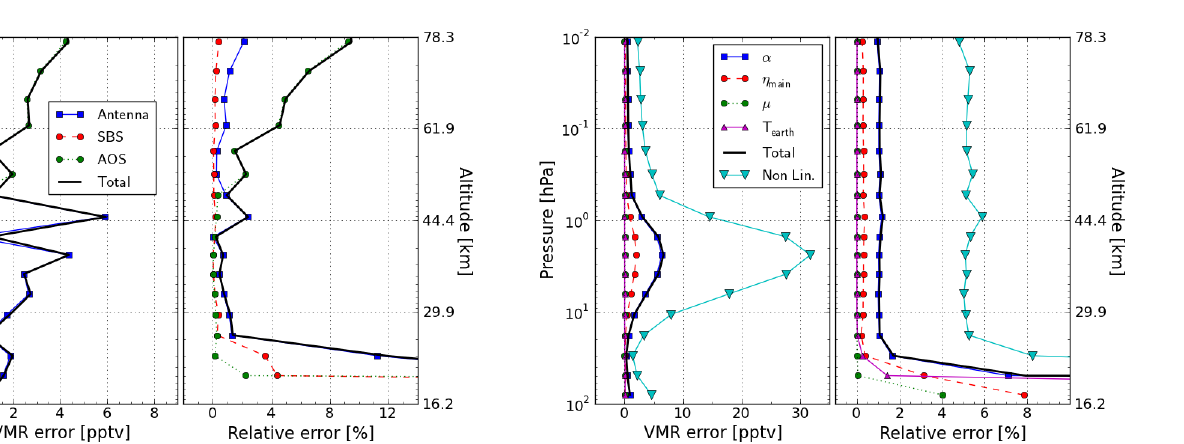
Fig. 7. Same as Fig. 4 except for the uncertainty in the calibration parameters. Blue: 20% uncertainty in the gain-compression parameter α . Red: 2% uncertainty in the main beam efficiency η main . Green: Total error due to 0.1% uncertainties in the Joule losses µ for mirrors (MR, SR, TR and SWM). Purple: 20K uncertainty in the temperature of the Earth T earth . Black: Total error due to the inaccuracies of the spectrum calibration. Cyan: Error due to nonlinearity being neglected between brightness temperature T and AOS output V .